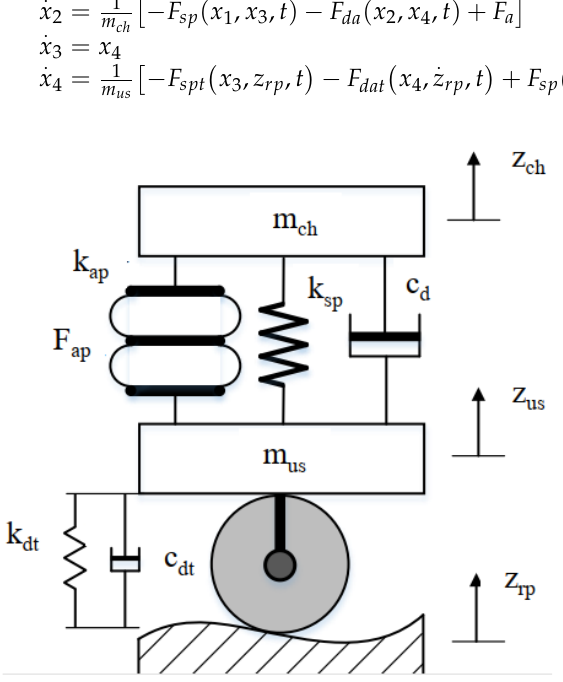
Figure 1. Pneumatic active suspension.